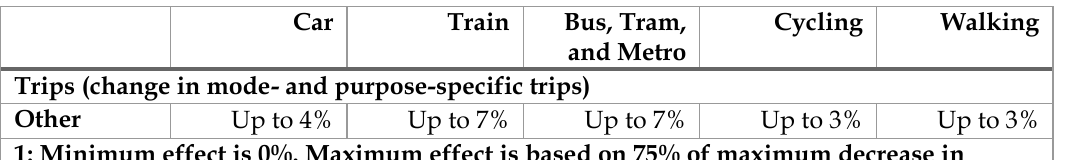
Expected range of changes1 in other trips due to working from home per mode (Results based on MPN questionnaire and travel diary) Car Train Bus, Tram, Cycling Walking and Metro Other Up to 4% Up to 7% Up to 7% Up to 3% Up to